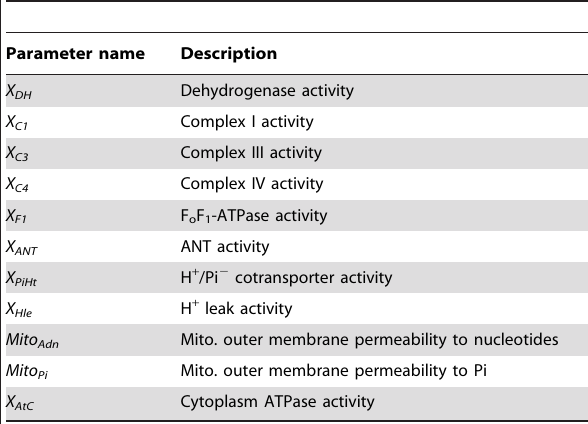
Table 1. Overview of mitochondrial model parameters included in the metabolic control